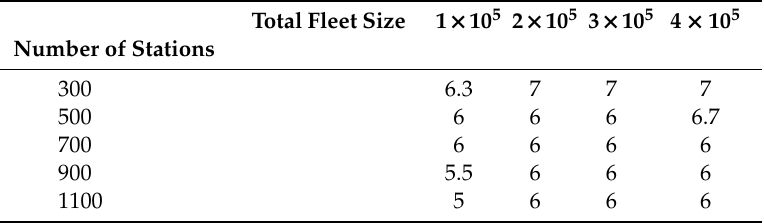
Table 3. Simulation data steady-state probability solution iteration number